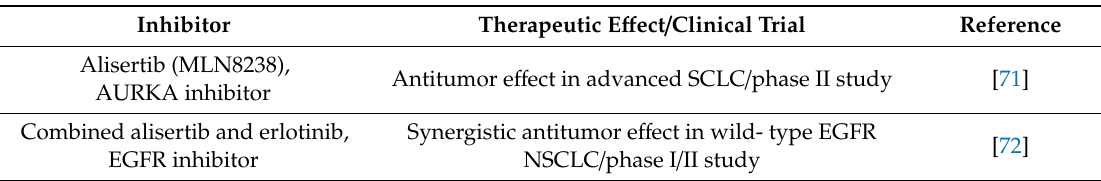
Table 4. Aurora Kinase Inhibitors in Clinical